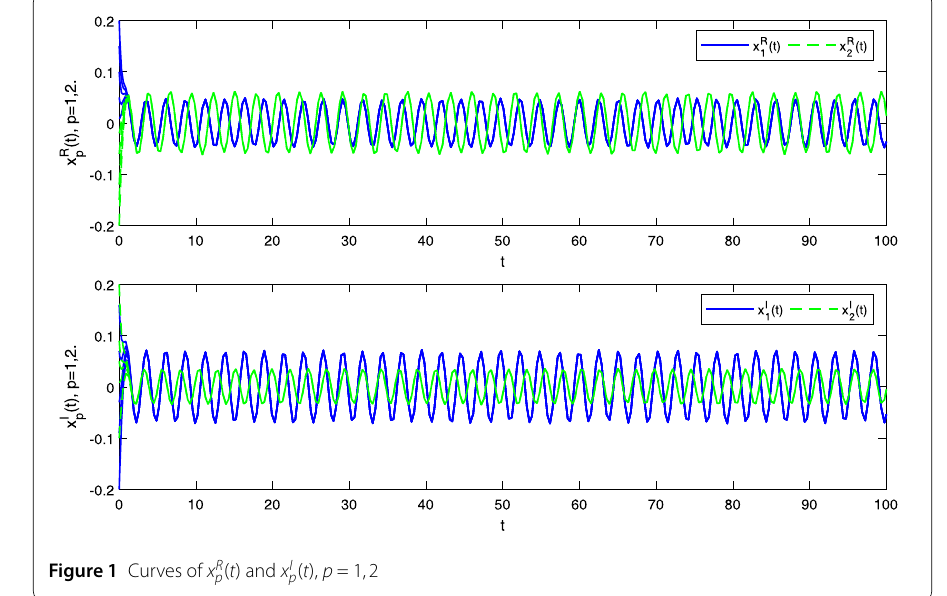
Figure 1 Curves of x R p ( t ) and x I p ( t ), p = 1,2